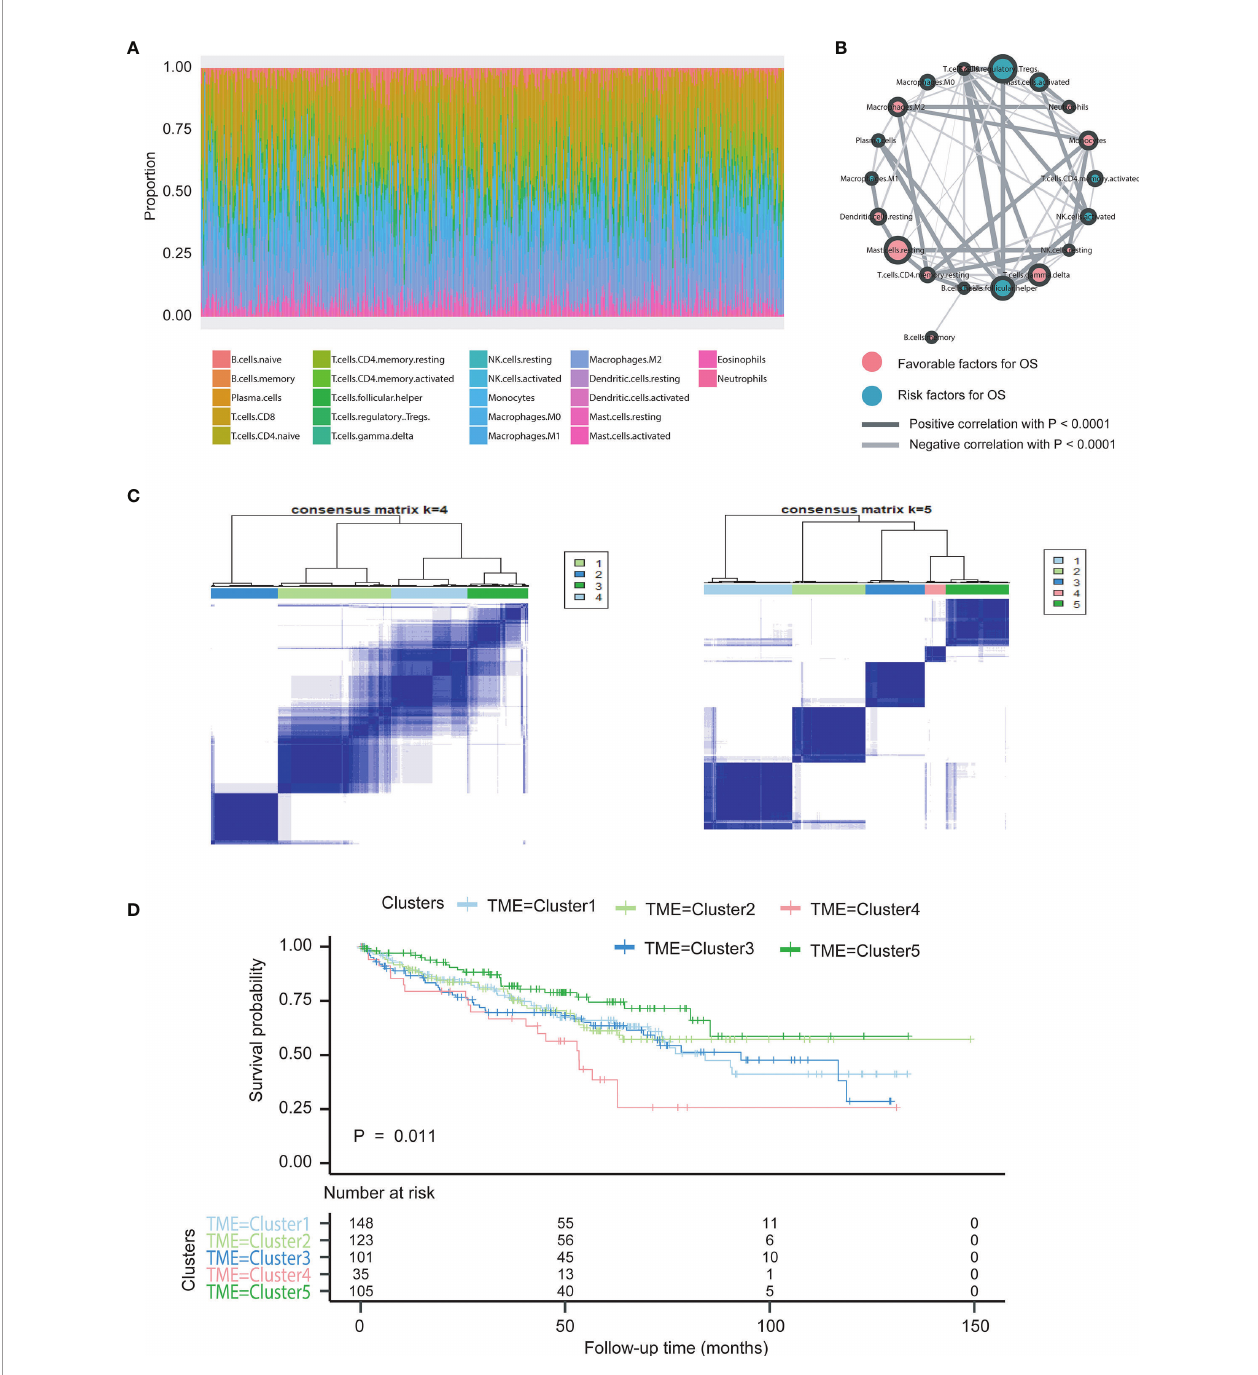
FIGURE 2 | Illustration of landscape of TME in ccRCC patients and characterization of TME subclusters. (A) The speci fi c 22 immune fractions represented by different colors in each sample were shown in barplot via CIBERSORT algorithm. (B) Cellular interaction of cell types in tumor micro environment. Favorable factors for overall survival were indicated in pink, and hazard factors for overall survival were shown in dark green. The lines connecting TME cells represented their cellular interactions, where the thickness of the lines indicated the strength of correlation calculated by Spearman correlation analysis. Positive correlation was indicated in black and negative correlation in silver. (C) Clustering analysis based on ConsensusClusterPlus package was conducted and indicates the optimized categories were 5 for classi fi cations of TME phenotypes. (D) Kaplan-Meier curves with log-rank test for overall survival (OS) of all cancer patients from seven two cohorts (TCGA, ICGC) with the TME in fi ltration classes. The number of patients in TMEcluster 1, 2, 3, 4 and 5 phenotypes were n=148, n=123, n=101, n=35, and n=105, respectively. Log-rank test showed an overall statistical result of P=0.011, where patients with TMEcluster 5 were with the most favorable